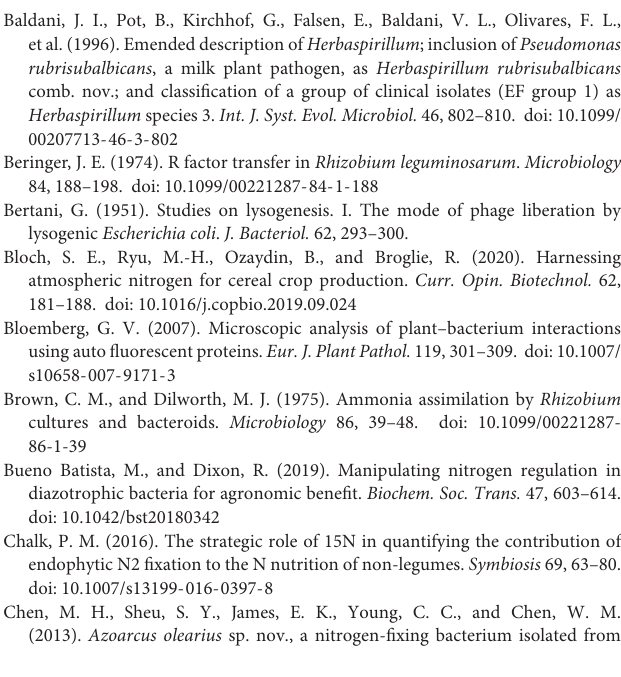
Supplementary Table 2 | Flow-cytometry cell counts and mean fluorescence intensity (MFI) values. Supplementary File 1 | Template for calculating C 2 H 4 production and nitrogenase activity from GC